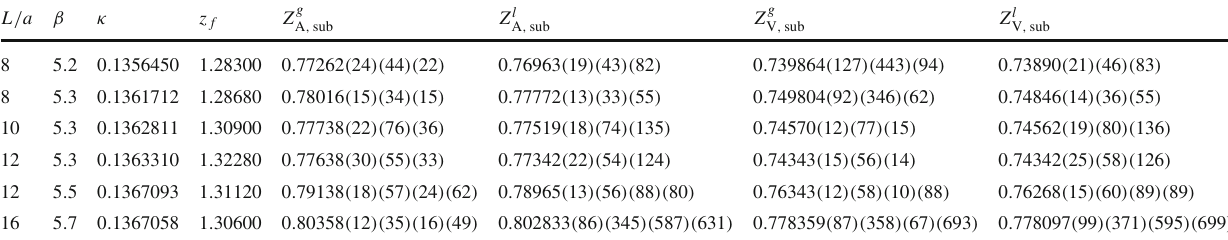
Table 11 Renormalization constants Z g ensembles. Lattice artefacts have been subtracted at O( g 2 bation theory. The four errors refer to (cf. Appendix B): statistical, systematic coming from the uncertainty on am cr ((cid:14) m atic coming from the uncertainty on z ∗ coming from maintaining the condition (4.2) ( (cid:14) x Z A , V ); the latter is only relevant for the last two ensembles. Comparing with the results of Table 10, only the mean values, statistical errors, and errors associated